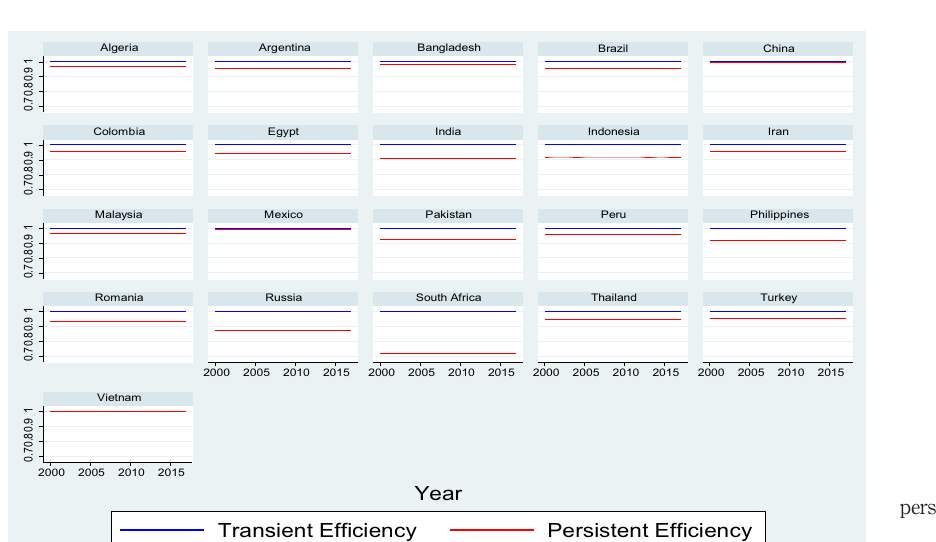
Figure 2. Persistent